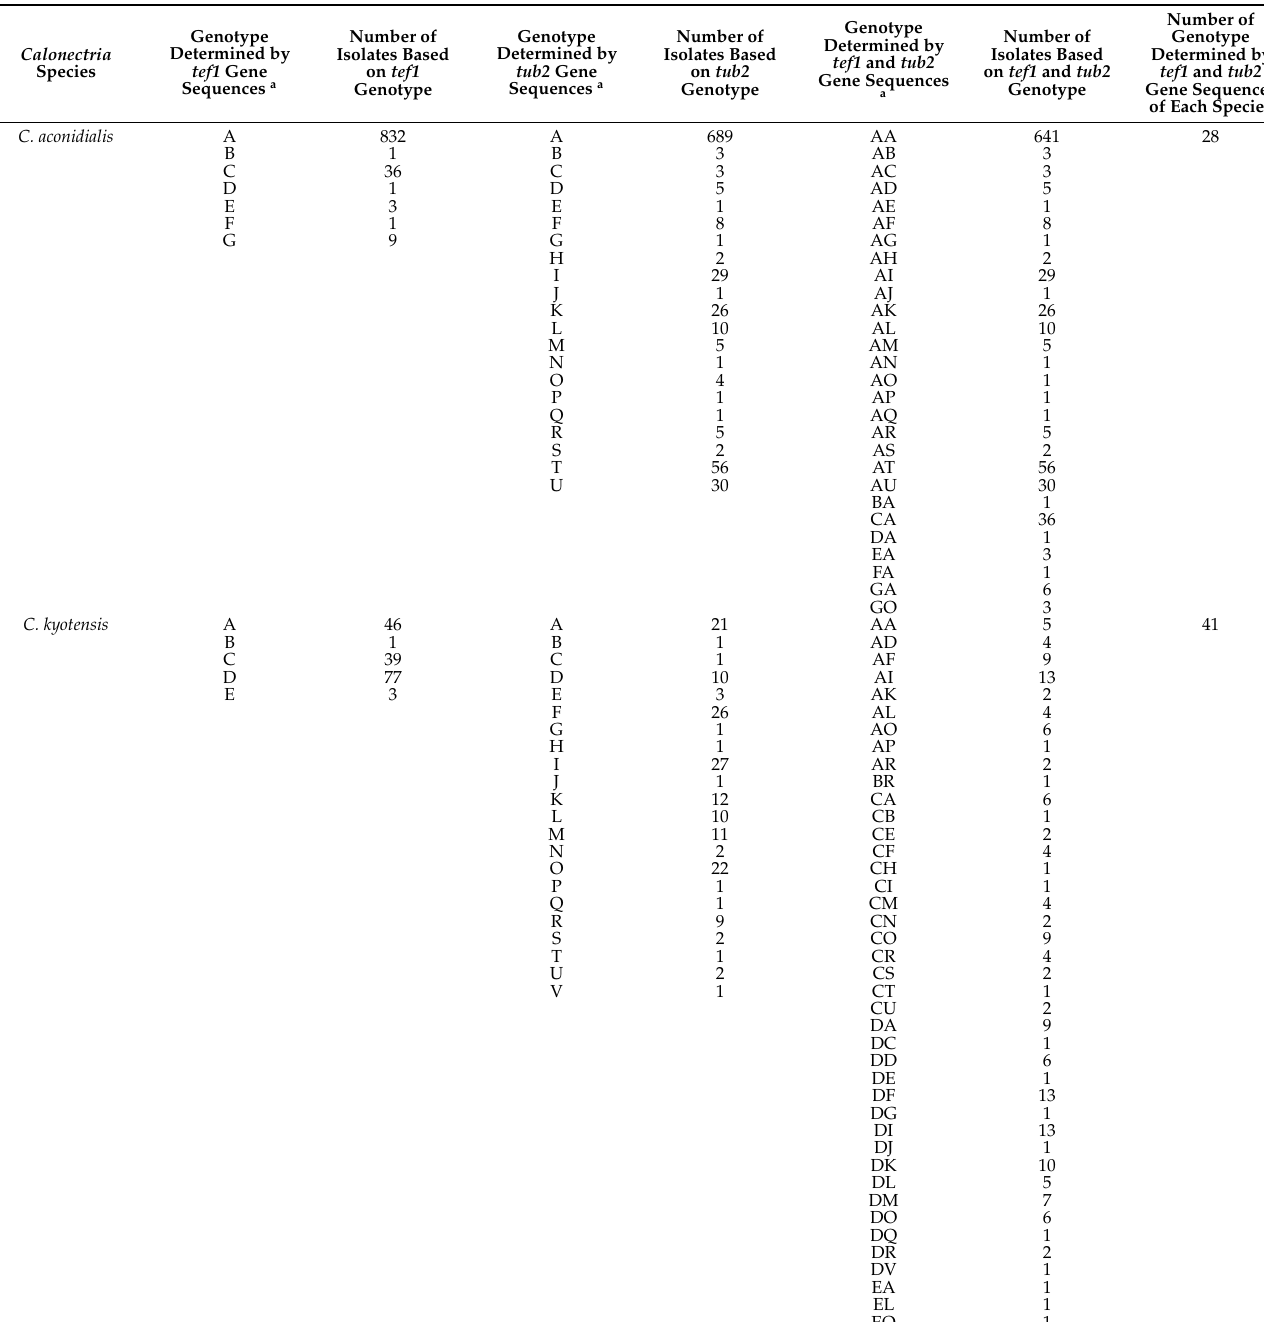
Table 2. Isolate numbers of each genotype of each Calonectria